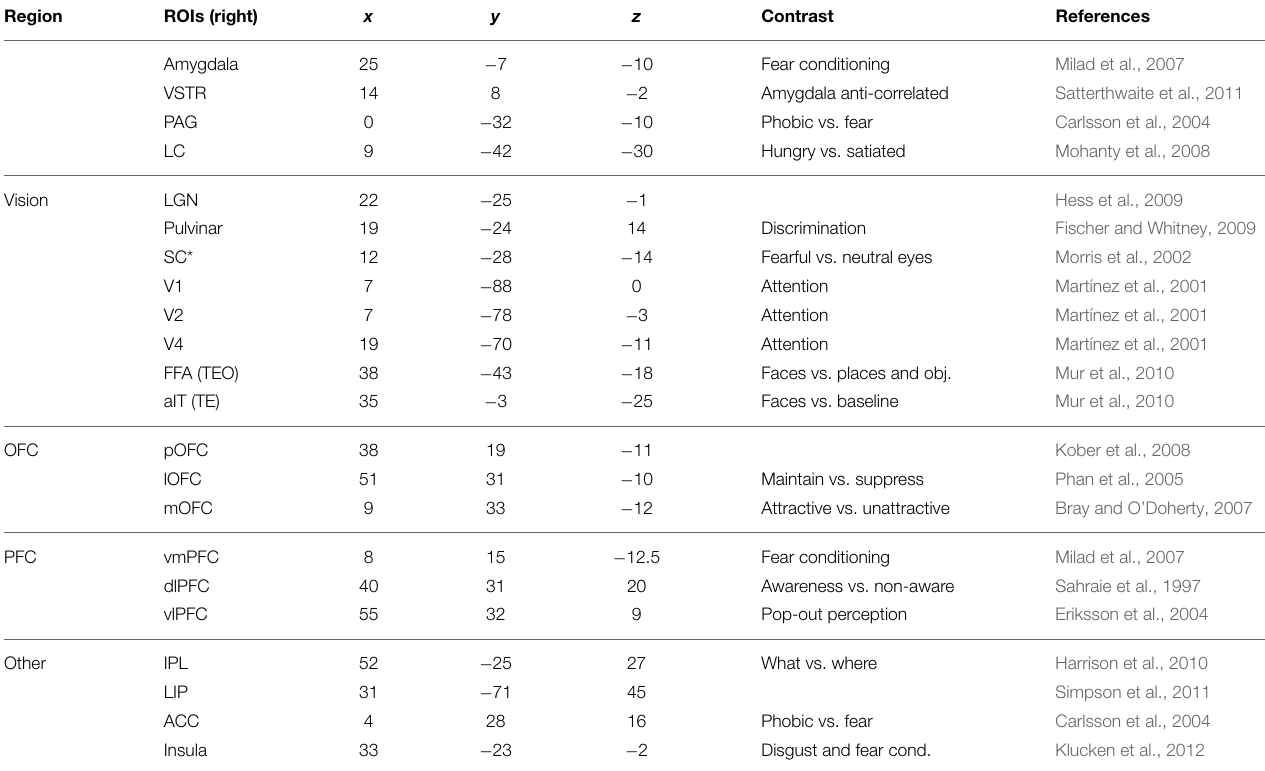
TABLE 3 | Regions of interest in visual fear processing (in Talairach space). Region ROIs